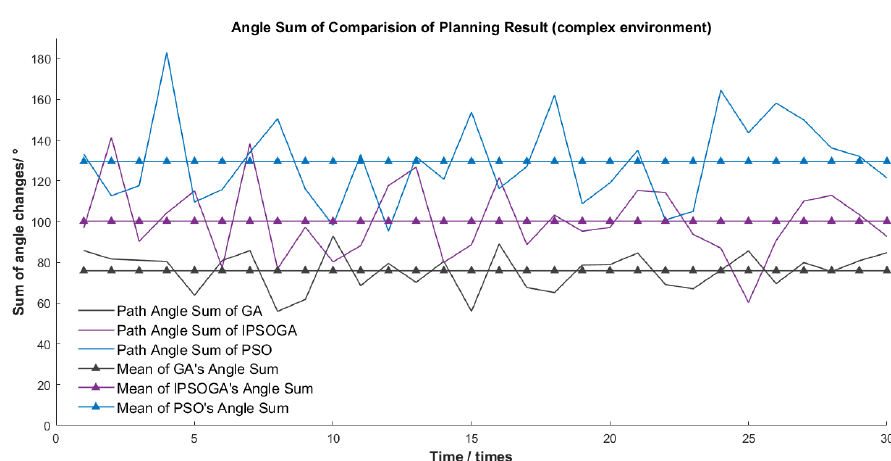
Figure 14. Comparison of Path Angle Sum (complex environment).